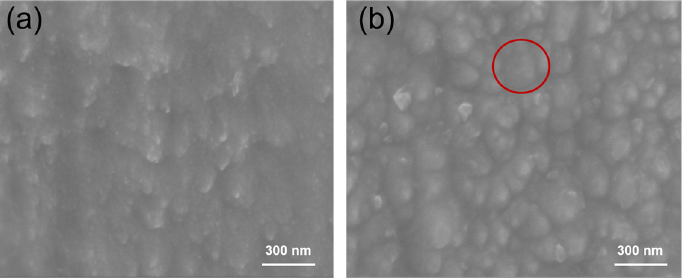
Figure 6. FE-SEM images of ferrite phase before and after thermal aging: ( a ) 0 h; ( b ) 15,000 h. The phase in the red circle is an α phase.